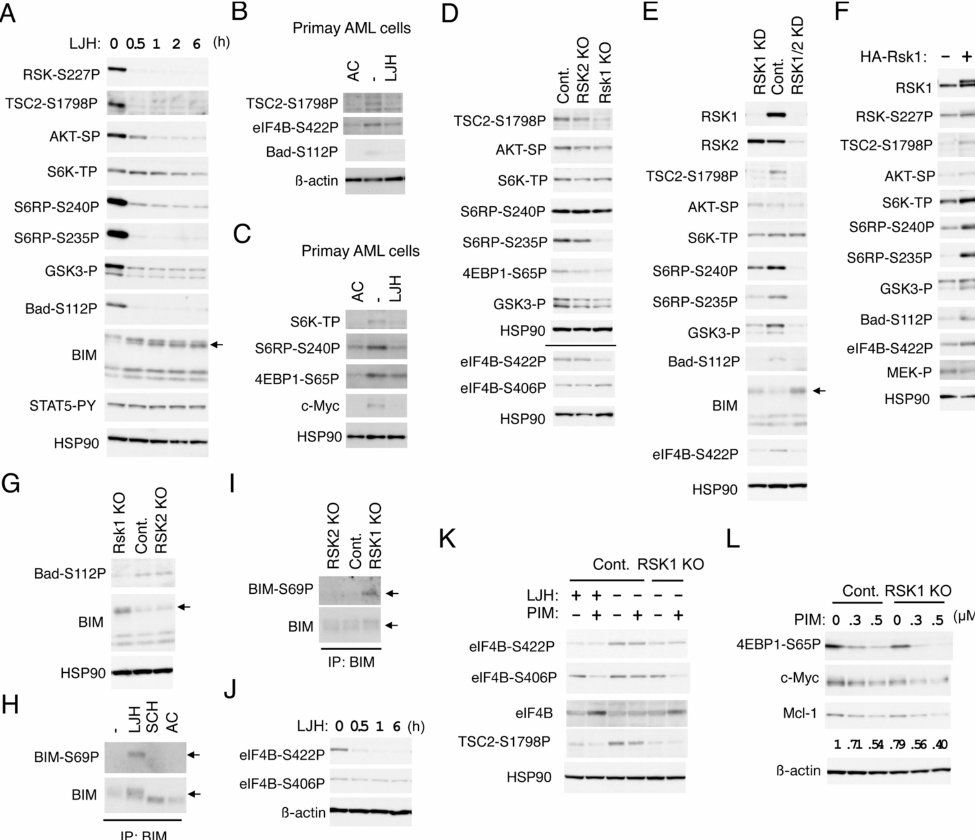
Figure5. RSK1activatesthemTORpathwaysandeIF4BcooperativelywithPIMandnegativelyregulates Bad and BIM-EL in FLT3-ITD-positive AML cells. ( A ) MV4-11 cells were treated with 5 µ M LJH685 (LJH) for indicated times. Cells were then lysed and subjected to immunoblot analysis with antibodies against indicated proteins. An arrow indicates the position of BIM-EL. Abbreviations: RSK-S227P, phospho-S227-RSK2; TSC2-S1798P, phospho-S1798-TSC2; AKT-SP, phospho-S473-AKT; S6K-TP, phospho-T389-p70S6K; S6RP-S240P, phospho-S240 / S244-S6RP; S6RP-S235P, phospho-S235 / S236-S6RP; GSK3-P, phospho-S21 / 9-GSK3 α / ß; Bad-S112P, phospho-S112-Bad; STAT5-PY, phospho-Y694-STAT5. ( B ) Primary FLT3-ITD-positive AML cells were treated for 24 h with or without 30 nM quizartinib (AC) or 5 µ M LJH685, as indicated, and analyzed. eIF4B-S422P: Phospho-S422-eIF4B. ( C ) Primary FLT3-ITD-positive AML cells were treated for 6 h with or without 20 nM quizartinib or 5 µ M LJH685, as indicated, and analyzed. 4EBP1-S65P: Phospho-S65-4EBP1. ( D ) MV4-11 cells knocked out (KO) of RSK1 or RSK2, as well as vector control cells (Cont.), as indicated, were analyzed. The results obtained from duplicate gels are shown above or below a horizontal line. eIF4B-S406P: Phospho-S406-eIF4B. ( E ) MV4-11 cells knocked down (KD) of RSK1 or both RSK1 and RSK2 (RSK1 / 2), as well as vector control cells (Cont.), as indicated, were analyzed. An arrow indicates the position of BIM-EL. ( F ) MV4-11 cells expressing HA-RSK1 ( + ) of vector control cells ( − ), as indicated, were analyzed. ( G ) Cells indicated were analyzed. An arrow indicates the position of BIM-EL. ( H ) MV4-11 cells were left untreated as control ( − ) or treated for 16 h with 5 µ M LJH685, 0.5 µ M SCH772984, or 10 nM quizartinib, as indicated, and lysed. Cell lysates were subjected to immunoprecipitation (IP) with ant-BIM antibody, followed by immunoblot analysis. An arrow indicates the position of BIM-EL. BIM-S69P: Phospho-S69-BIM. ( I ) Cells indicated were analyzed. ( J ) MV4-11 cells were treated with 5 µ M LJH685 for indicated times and analyzed. ( K ) Vector control MV4-11 cells or RKS KO cells were treated for 6 h with 1 µ M LJH685 or 0.1 µ M PIM-447 (PIM), as indicated, and analyzed. ( L ) Indicated cells were treated for 6 h with indicated concentrations of PIM-447 and analyzed. Relative expression levels of Mcl-1 were determined by densitometric analysis and are shown below the